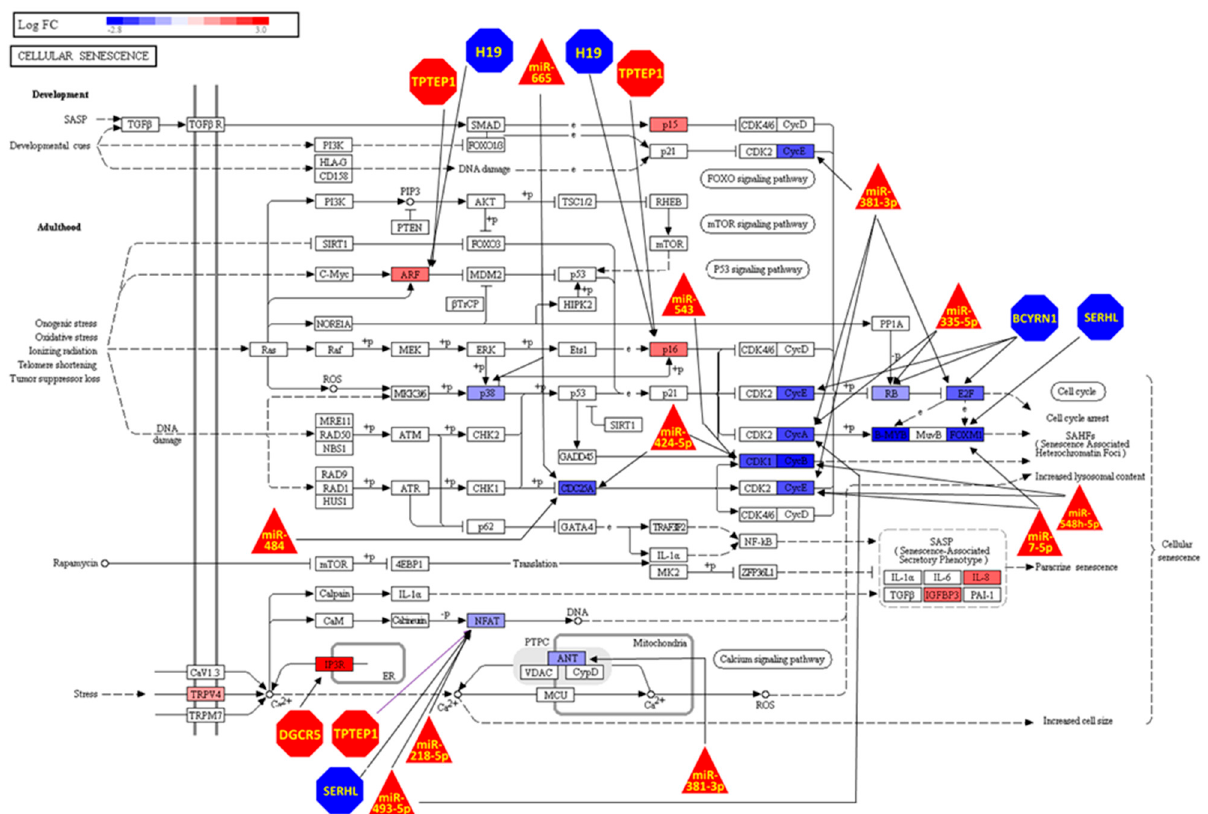
Figure 4. Cell Senescence KEEG pathway genes being regulated by ncRNAs due Cell Senescence. The transcription factor NFAT1 is the target of many ncRNAs. DE RNAs threshold in limma was log 2 Fold Change ≥ |1| and adjusted p-value (FDR) < 0.01. KEGG Pathway depiction was generated using Advaita iPathwayGuide. Blue indicates down-regulated and red up-regulated in senescent cells relative to non senscent cells. Genes are presented as rectangles, miRNAs as triangles, and lncRNAs as octagons.